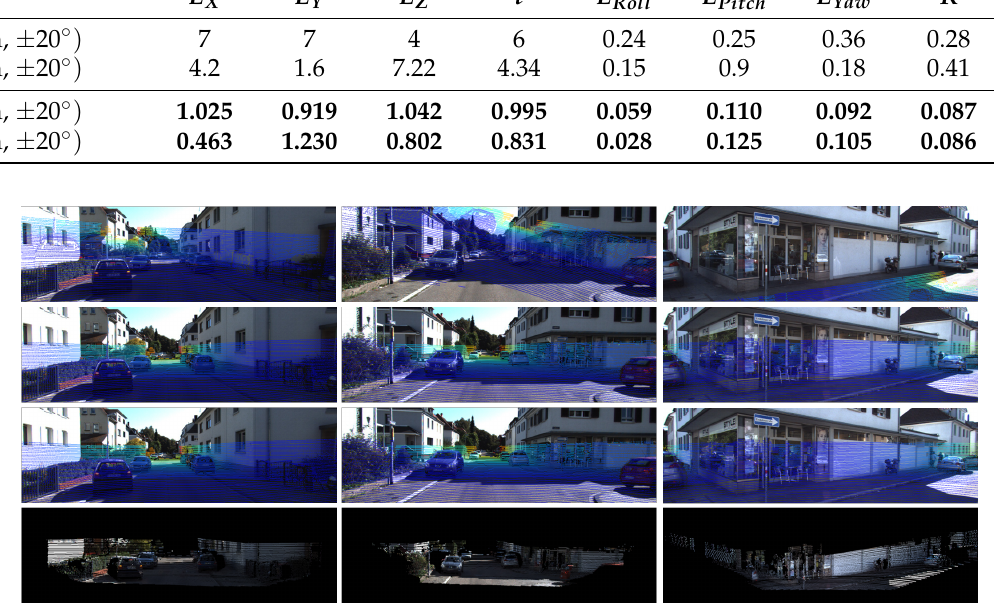
Figure 5. Examples of the calibration results on the T1 test dataset. The first row shows the mis- calibrated LiDAR point clouds projected onto the image plane given initial extrinsic parameters. The second row shows the projected LiDAR point clouds using CFNet’s prediction, and the third row shows the corresponding ground truth. The last row shows the colorized point cloud with the predicted extrinsic